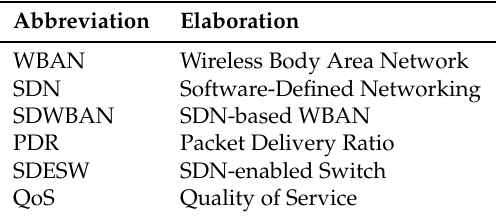
Table 1. List of